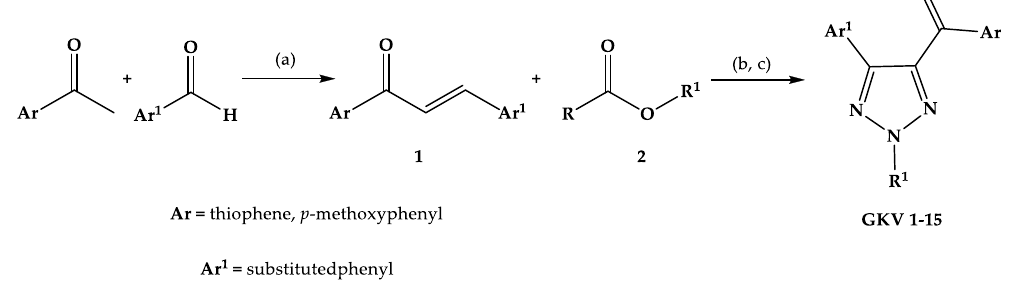
Scheme 1. Synthesis of the title compounds GKV1–15. Reagents and conditions: (a) 6N NaOH, Ethanol, 5 h, r.t; (b) NaN 3 , ZrO 2 -Cu 2 - β -CD, DMF, 100 ◦ C, stirred, 15 h; (c) 100 ◦ C, stirred, 16